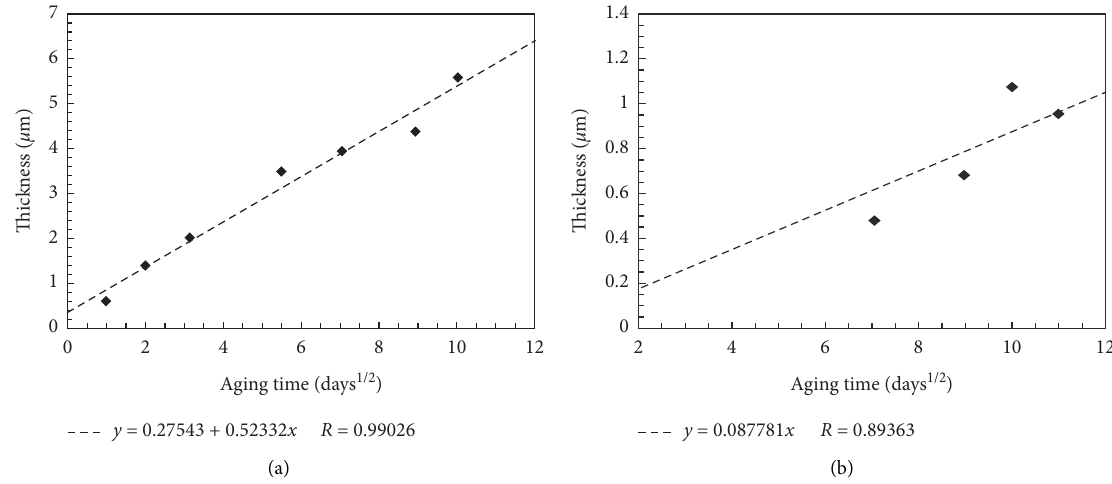
Figure 2: Thickness of (a) the Cu-Au layer and (b) the Cu